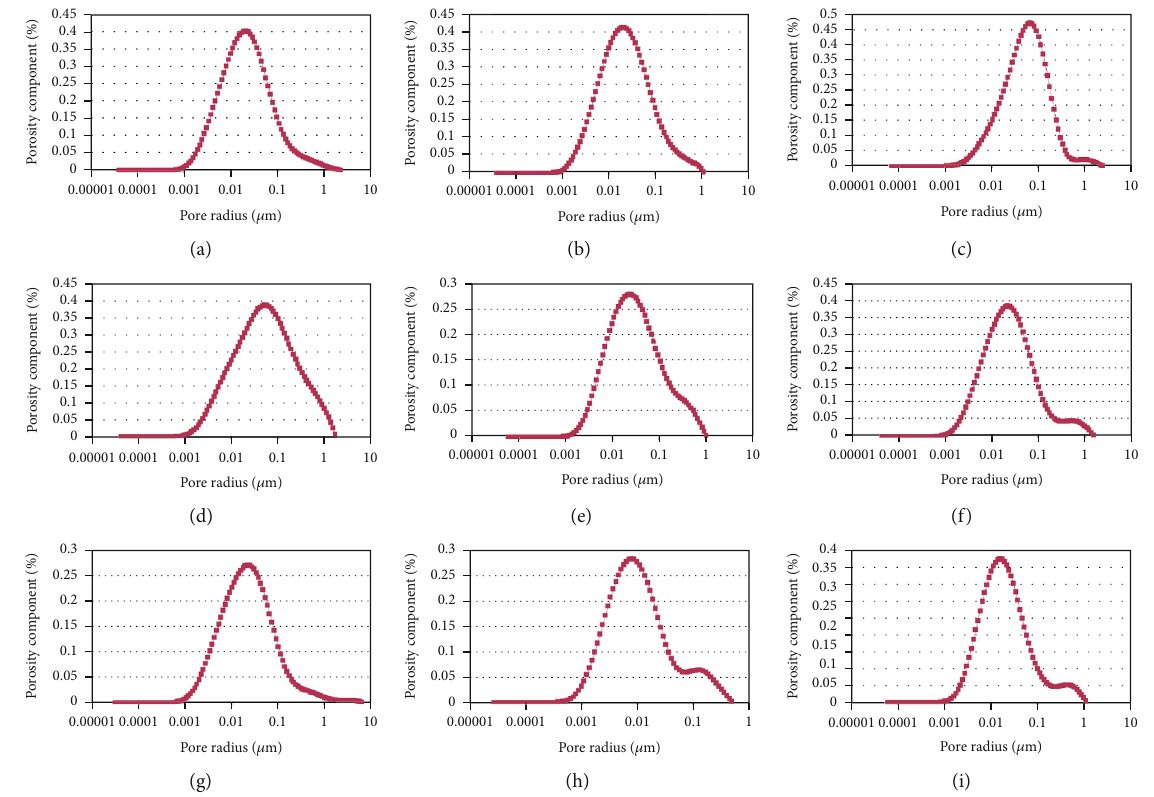
Figure 6: Conversion results of pore size distribution for some typical rock samples: (a) B64-3, (b) B64-29, (c) B64-33, (d) B64-38, (e) B64-42, (f) B65-8, (g) M5-1, (h) M5-6, and (i)